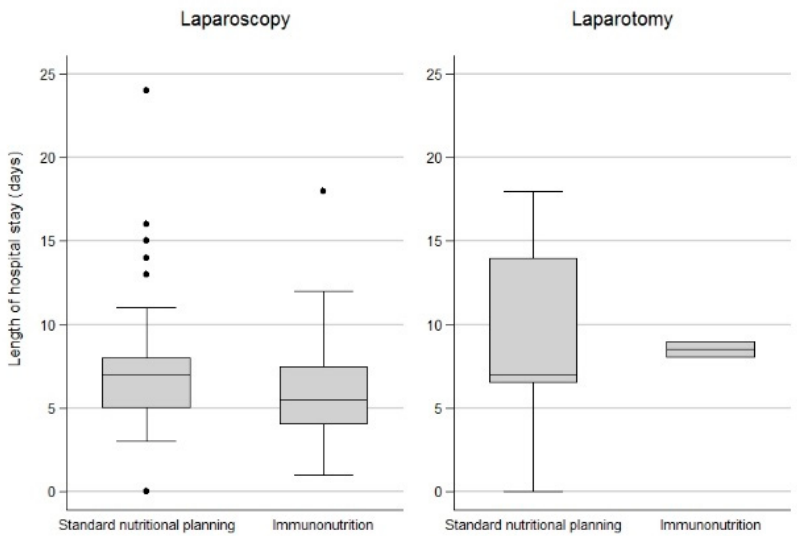
Figure 1. Length of hospital stay in IN and non ‐ IN group according to surgical procedure (laparoscopy versus laparotomy), box plot.